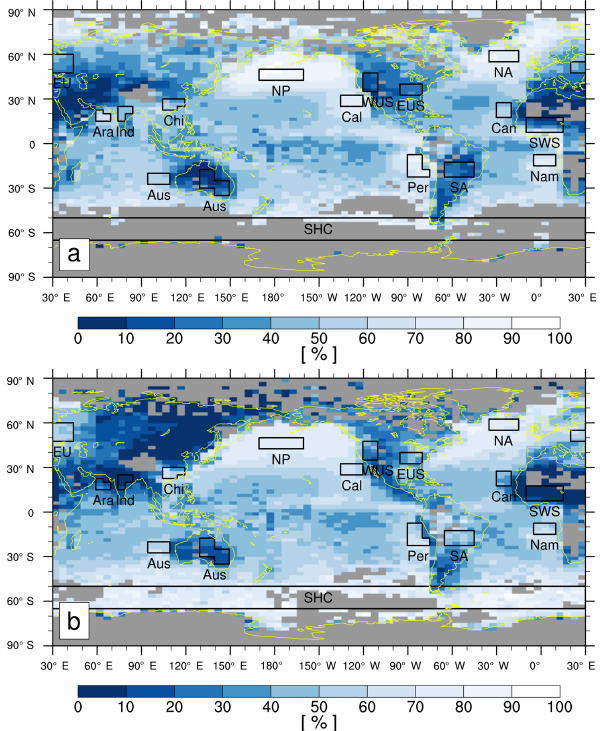
Figure 7. The seasonal climatology of LCA during (a) JJA and (b) DJF in the 2.5 ◦ latitude × 5 ◦ longitude grid box. The grid boxes with a climatological observation number below 25 in each season are masked by gray color. The domains selected for com- puting temporal (seasonal–interannual and interannual only) cor- relation coefficients in Tables 2 and 5 are also plotted: